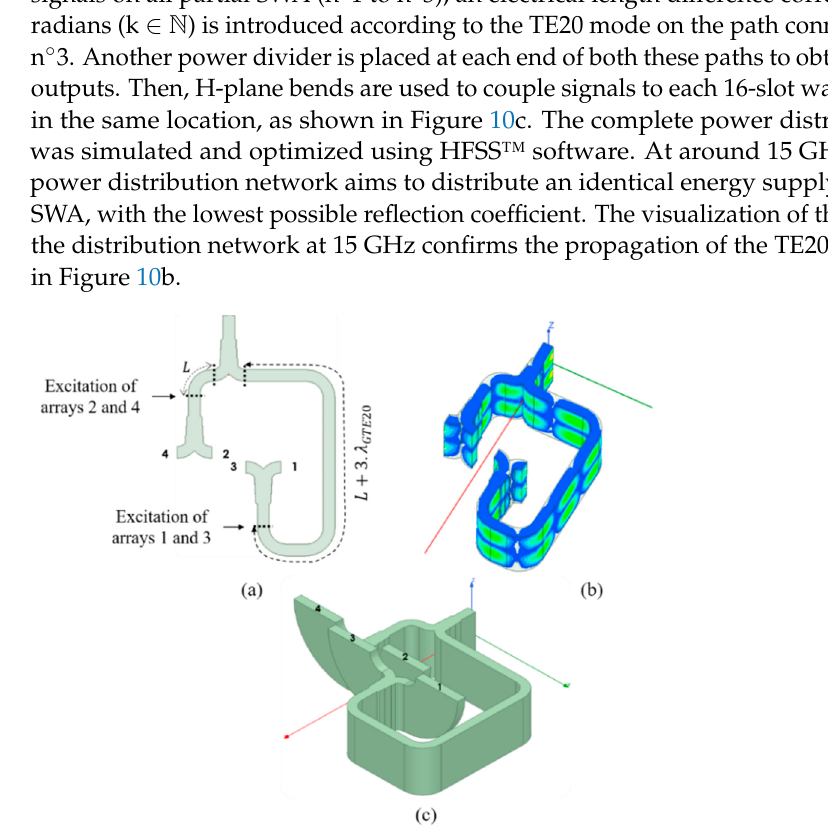
( b ) Figure 9. Measured and simulated co- and cross-polarization radiation patterns at 15 GHz of the 16- slot waveguide antenna: ( a ) E-plane and ( b ) H-plane.